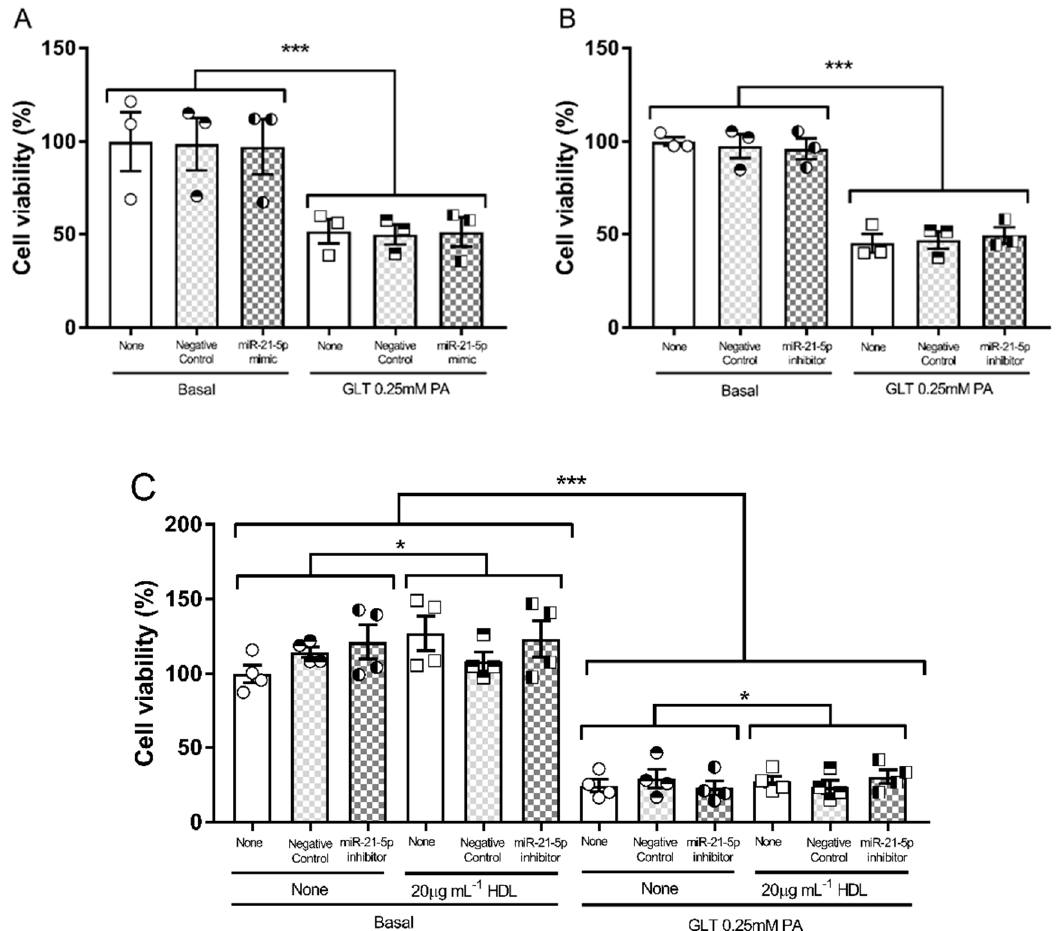
Figure 6. The influence of 5 nM miR-21-5p mimic or 10 nM miR-21-5p inhibitor on the response of 1.1B4 cells to GLT challenge was assessed by conversion of MTT to formazan, normalized to the basal condition, is shown in ( A , B ), respectively. This showed that while there was a significant effect of GLT challenge on cell viability in both figures, neither the miR-21-5p mimic or inhibitor modulated the impact of GLT change on the 1.1B4 cells; values are mean ± SEM of three independent experiments, analysed by two-way ANOVA and post hoc (Dunnett’s) test *** p < 0.001. The effect of the miR-21-5p inhibitor in the presence of HDL (20 µ g mL − 1 ) is shown in ( C ). The GLT challenge adversely affected cell viability and there was a significant protective effect of HDL; mean ± SEM of four independent experiments, analysed by three-way ANOVA and post hoc (Dunnett’s) test; * p < 0.05 and *** p <